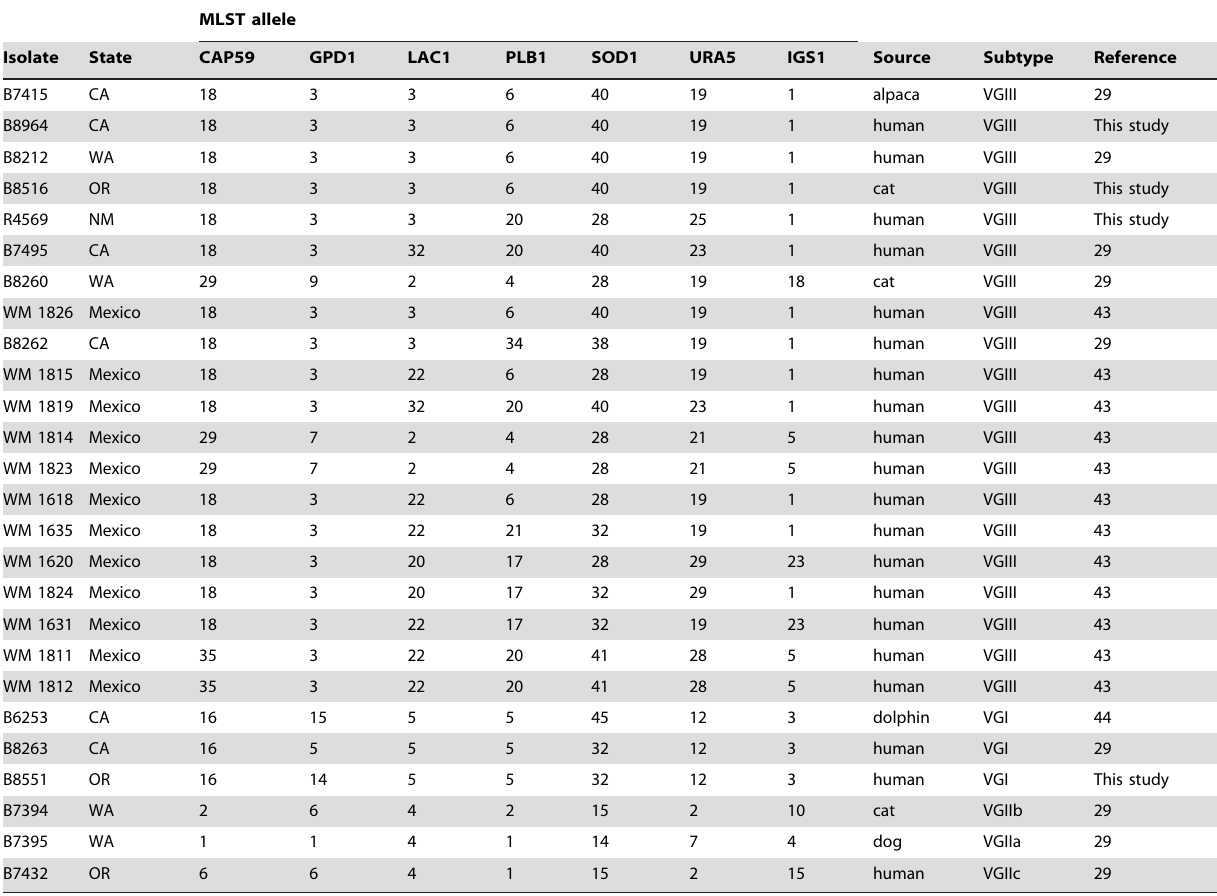
Table 1. Isolates used for comparison in this